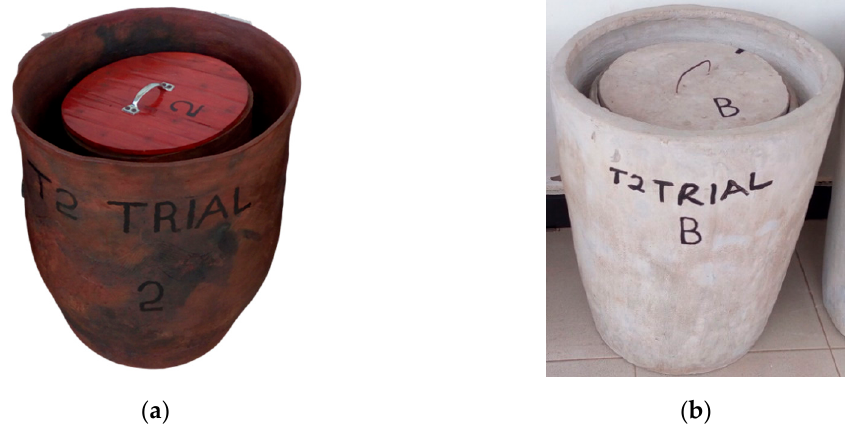
Figure 2. Second generation Zeepot ( a ) Clay and ( b ) Cementsand prototypes manufactured and tested during the refinement phase.